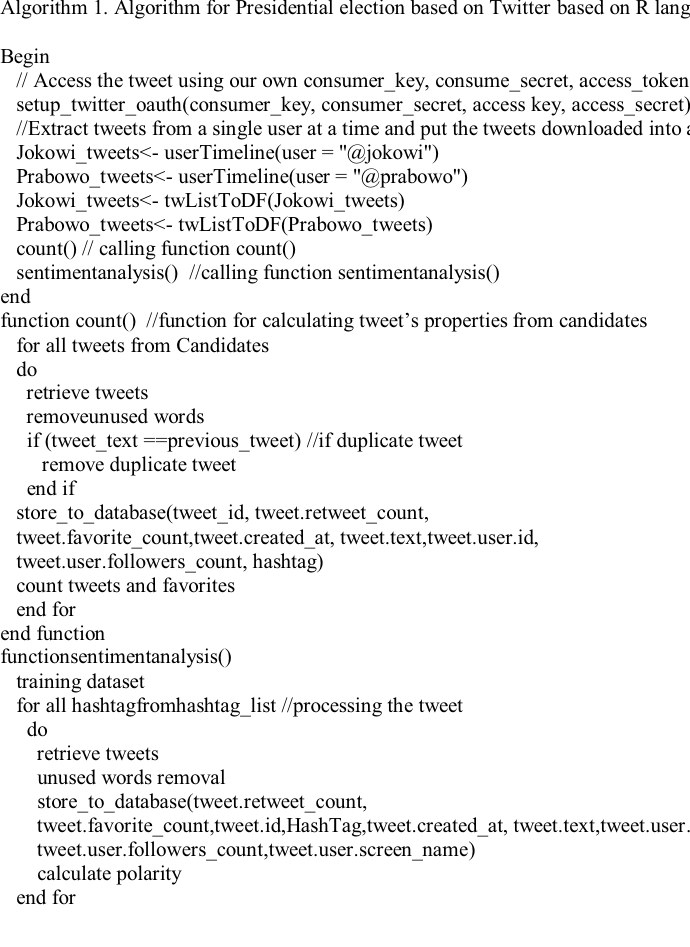
Algorithm 1. Algorithm for Presidential election based on Twitter based on R language and